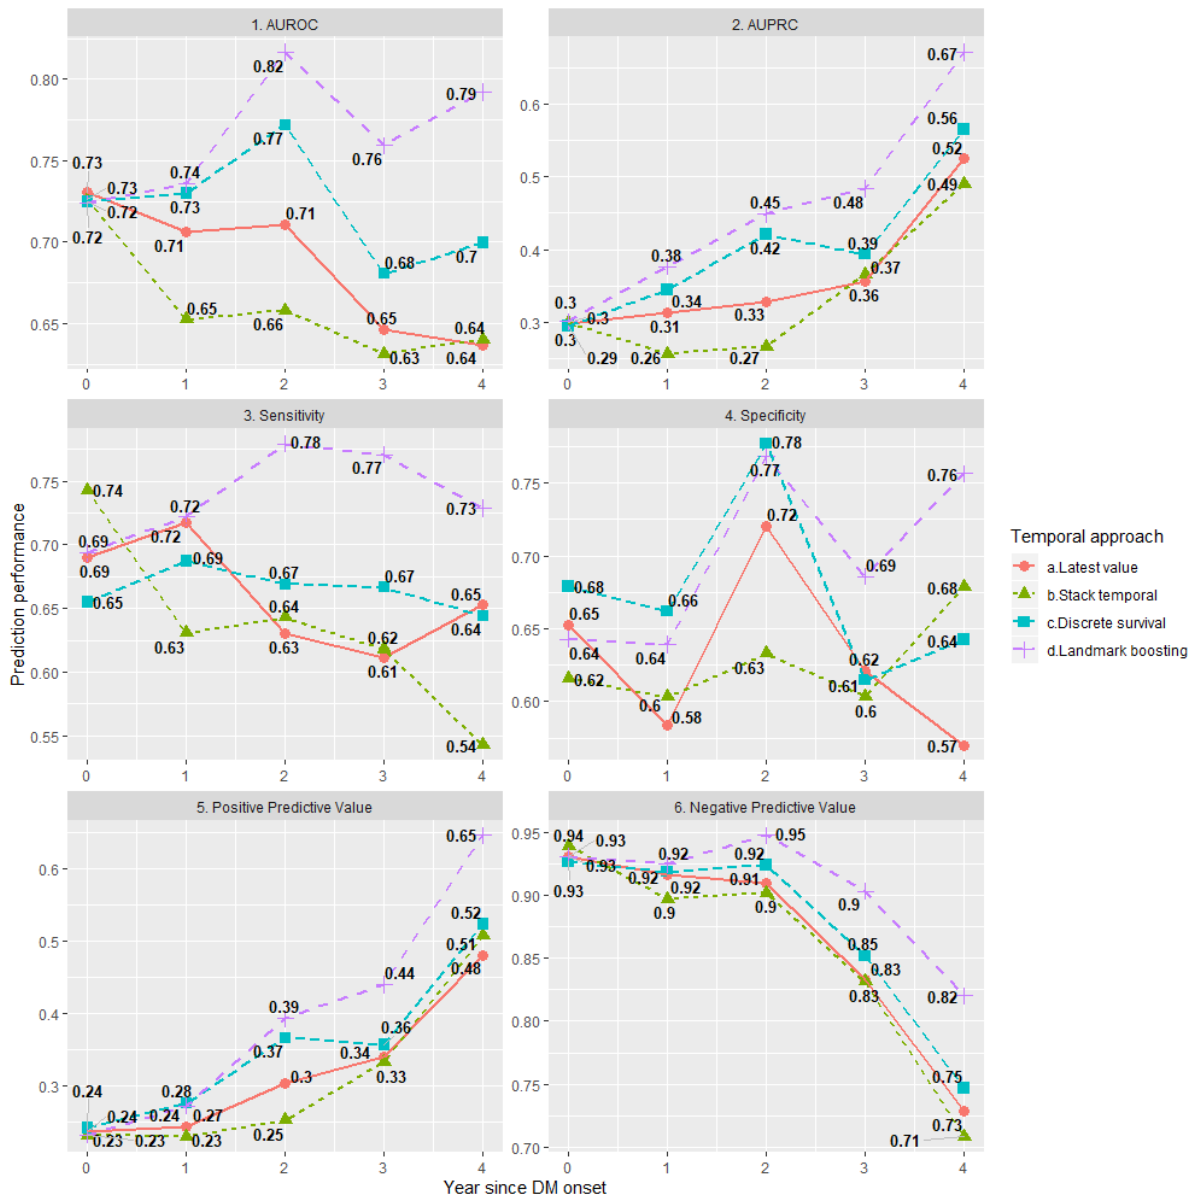
Figure 5. Performance comparisons among temporal approaches over landmark time. Area under receiver operating curve (AUROC) and area under the precision-recall curve (PRAUC) are first reported. For fair comparisons, sensitivity, specificity, positive predicted value, and negative predicted value are calculated by treating testing examples with predicted probability of outcome in the top 40th percentile as positive cases. Here, 95% bootstrap confidence intervals are reported for each metric at each landmark time (ie, full year since diabetes mellitus [DM] onset). The bootstrap confidence intervals are generated based on 30 bootstrapped samples, and used 2.5th percentile, 50th percentile, and 97.5th percentile to construct the confidence intervals for each